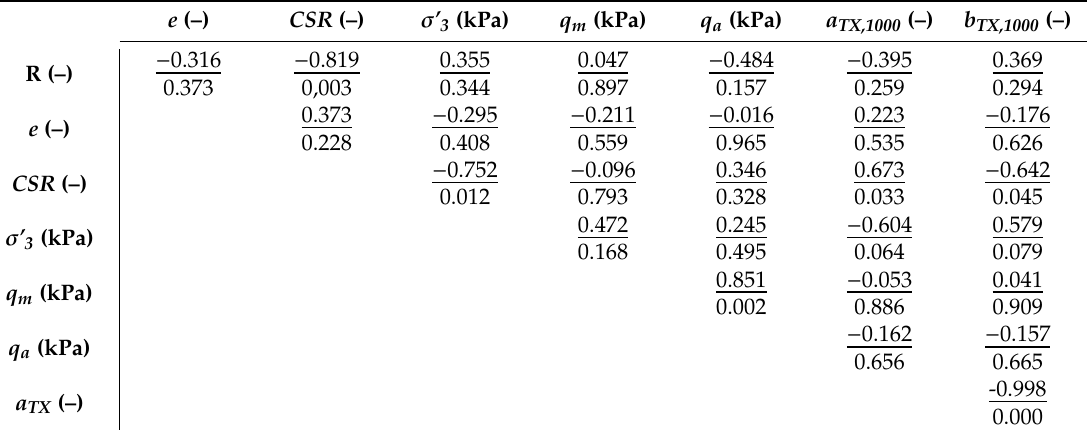
Table A4. Pearson correlation analysis result for a TX and b TX parameters.